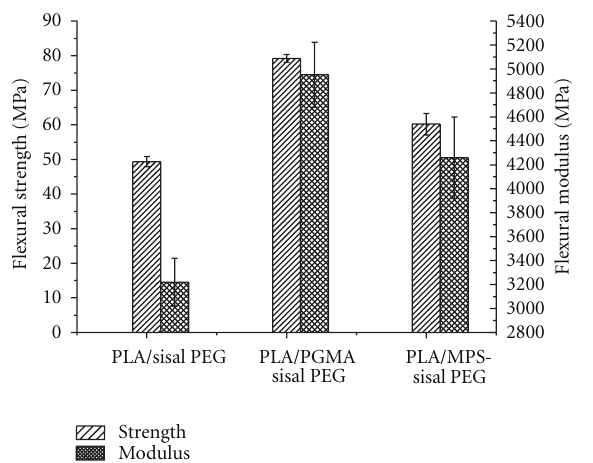
Figure 4: Flexural properties of PEG-Plasticized PLA and 30wt.% sisal fiber composites.